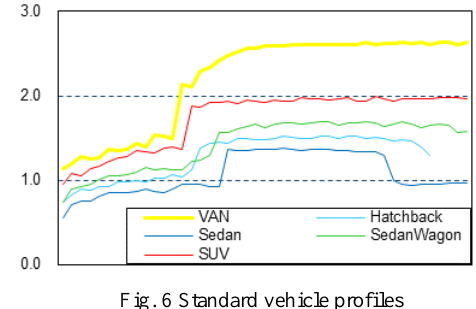
Fig. 6 Standard vehicle profiles